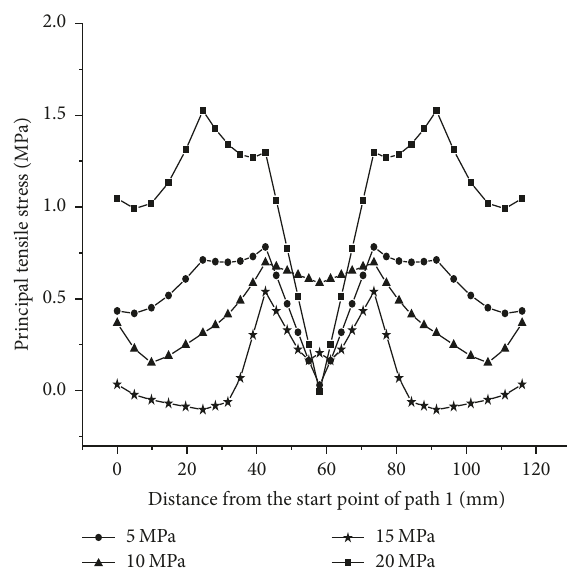
Figure 20: Comparison of the principal tensile stress generated along path 1 from corrosion-induced expansion when the displace- ment resulting from corrosion-induced expansion reaches 0.01 mm.